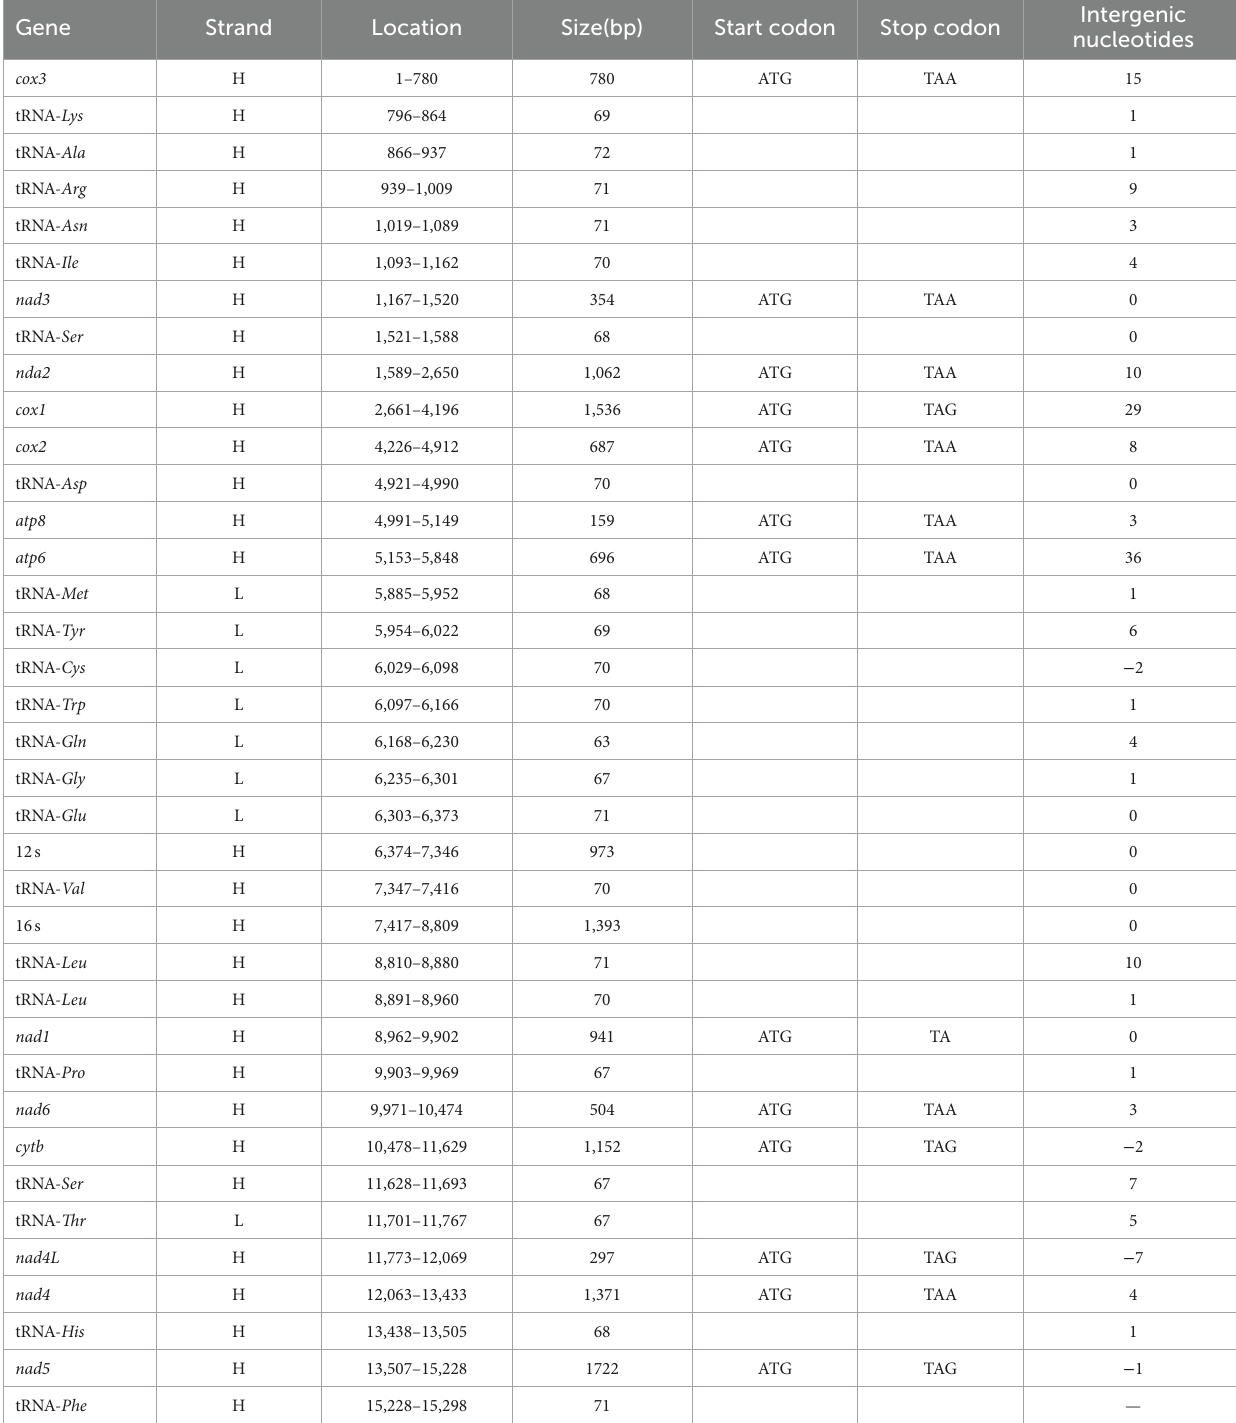
TABLE 5 Gene annotation of the complete mt genome of M.